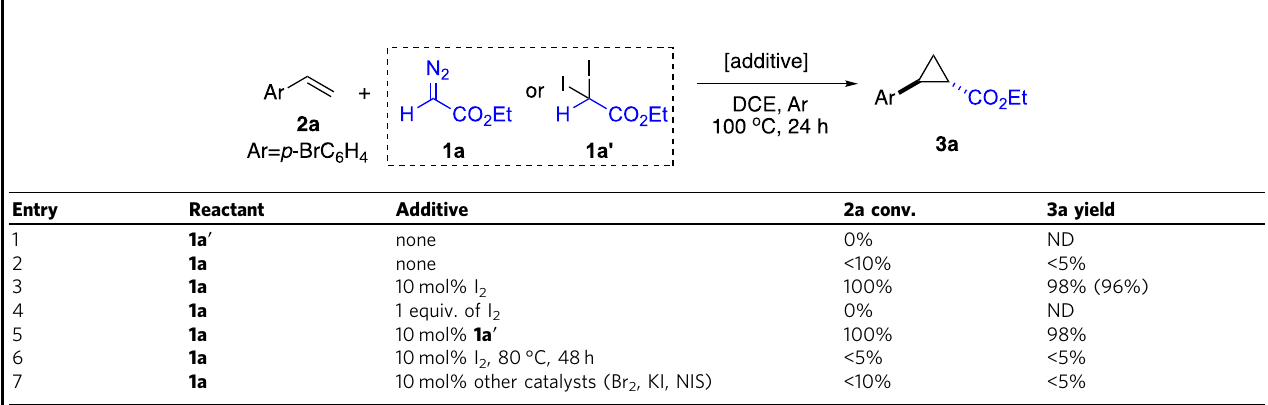
Entry Reactant Additive